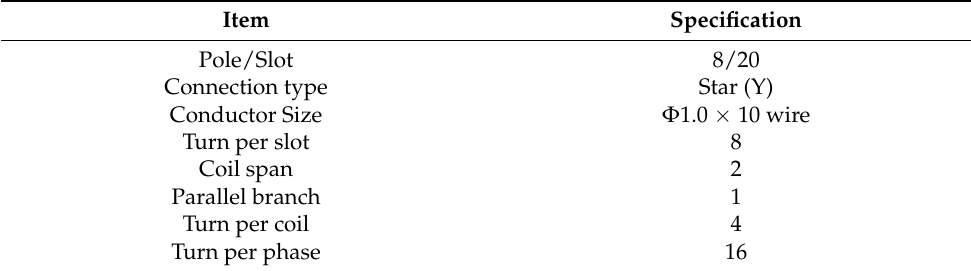
Table 1. Design parameters of the five-phase